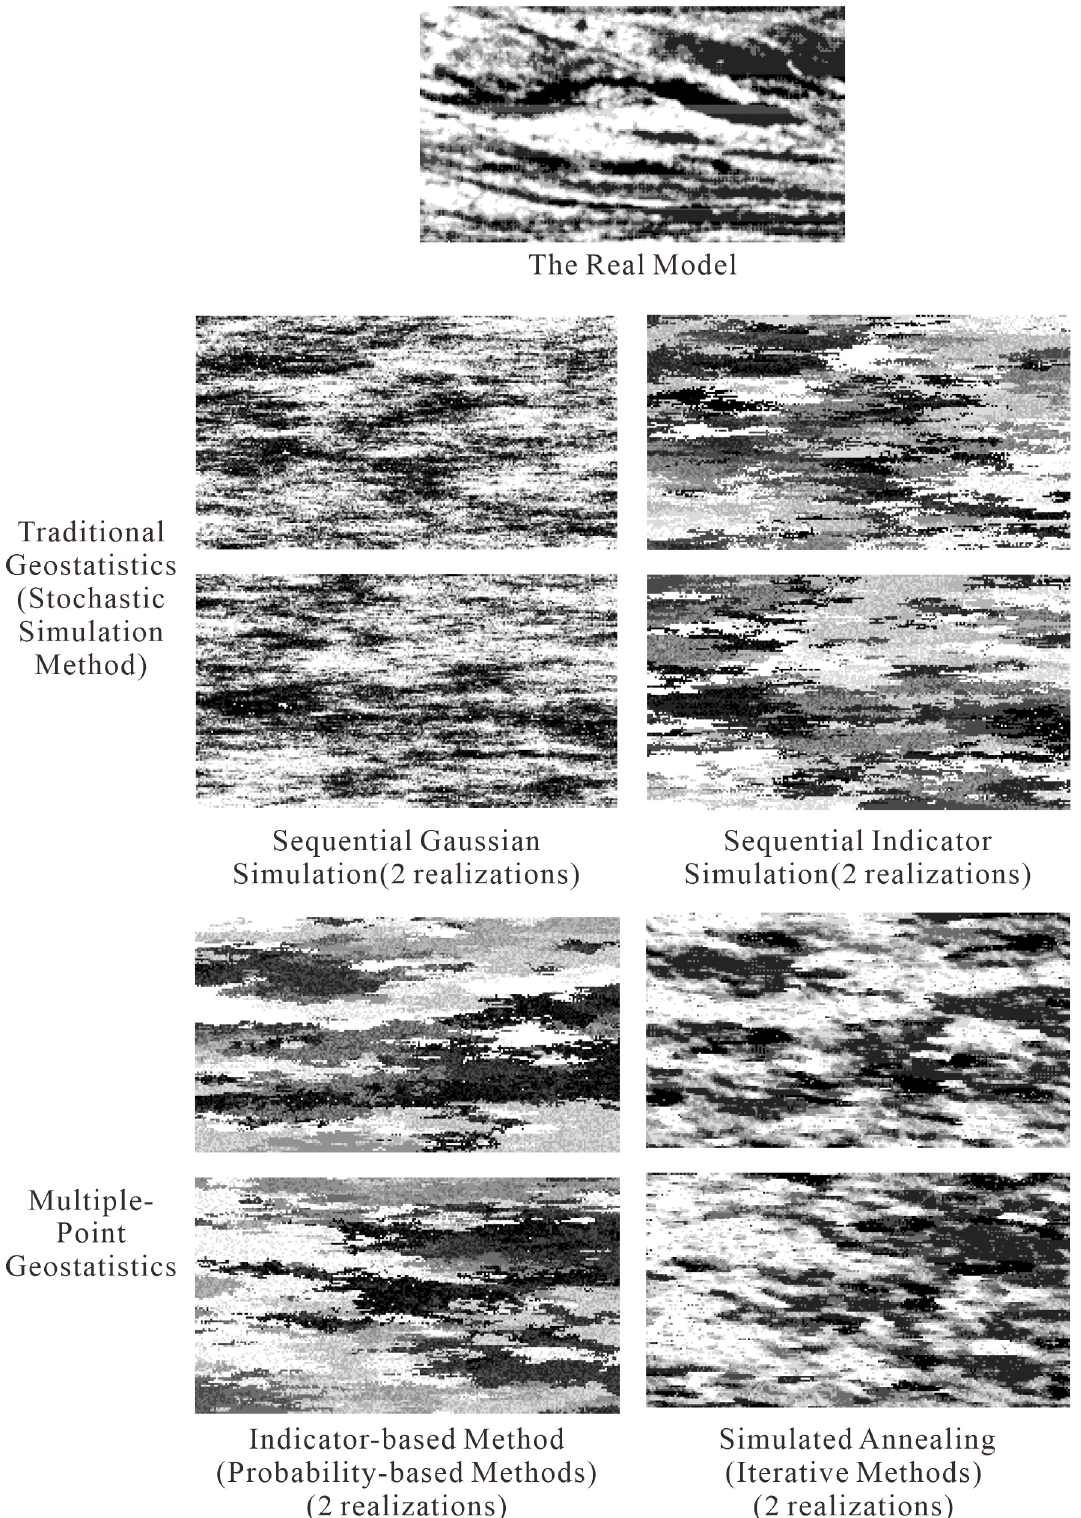
Figure 6. Comparison of Traditional Geostatistics and Multiple-Point Geostatistics Methods for the same model: the Sequential Gaussian Simulation and Sequential Indicator Simulation belong to the Tradition Geostatistics and Indicator-based Methods, and Simulated Annealing belongs to Multiple-Point Geostatistics (edited from [78]).